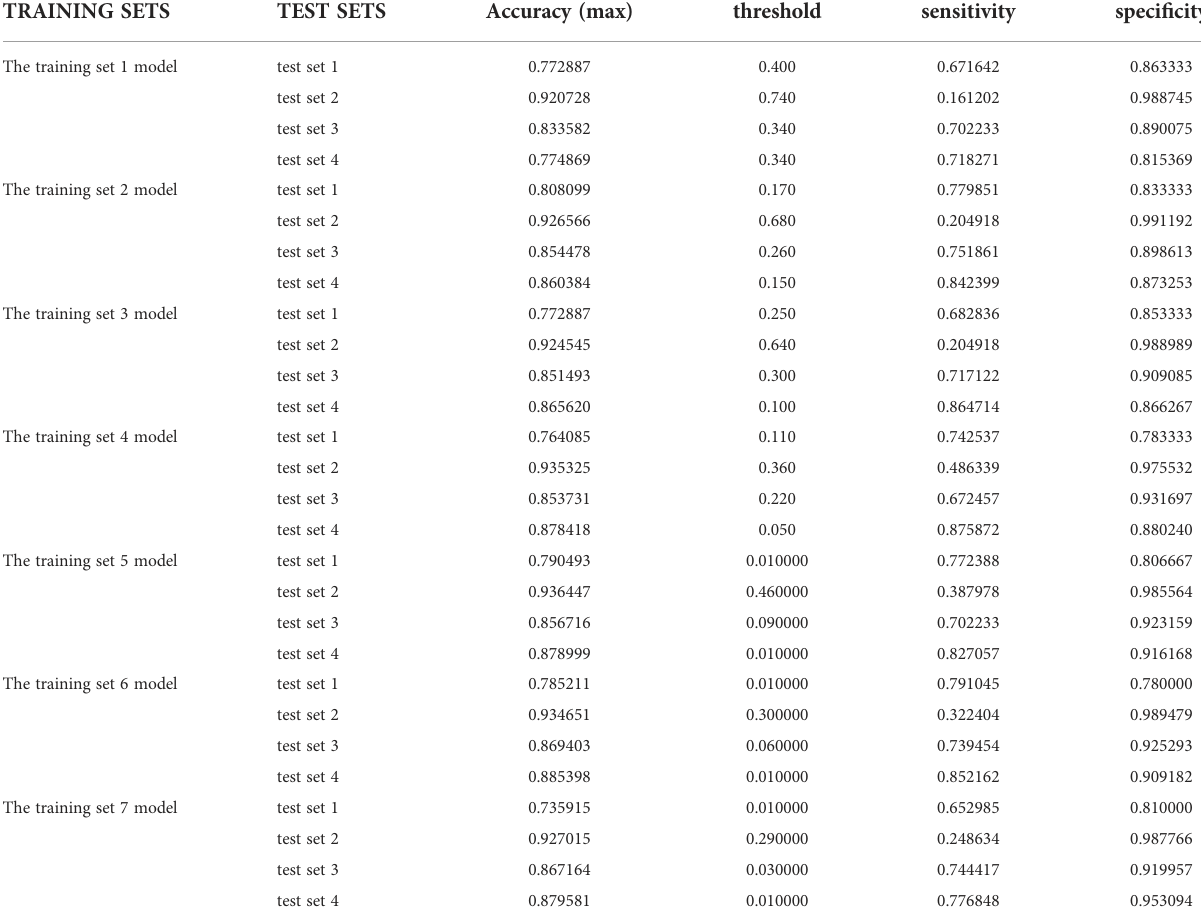
TABLE 2 The results of testing four test sets for each of the seven training set models. TRAINING